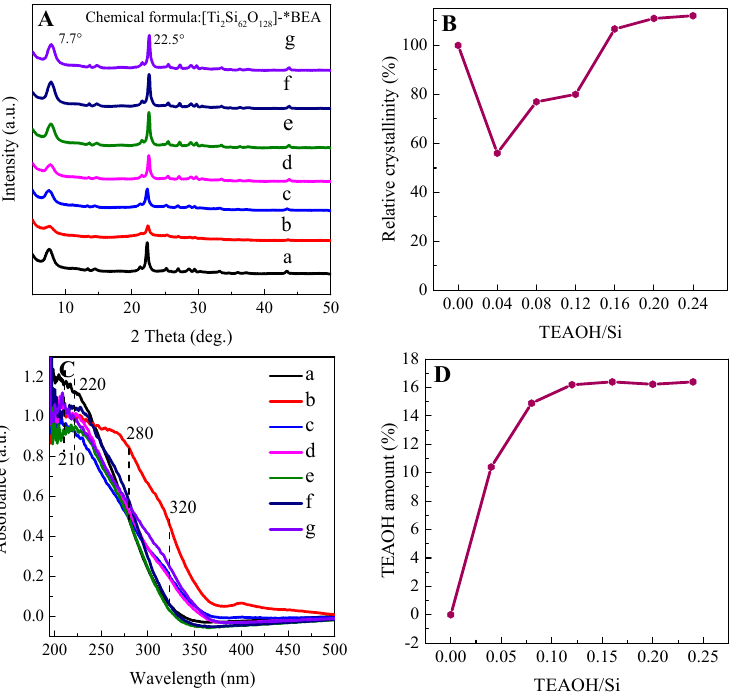
Figure 3. XRD patterns ( A ), crystallinity change ( B ), UV − Vis spectra ( C ) and occluded TEAOH amount ( D ) of the pristine Ti − Beta (a) and Re − Ti − Beta postsynthesized by different TEAOH/Si ratios of 0.04 (b), 0.08 (c), 0.12 (d), 0.16 (e), 0.20 (f) and 0.24 (g).